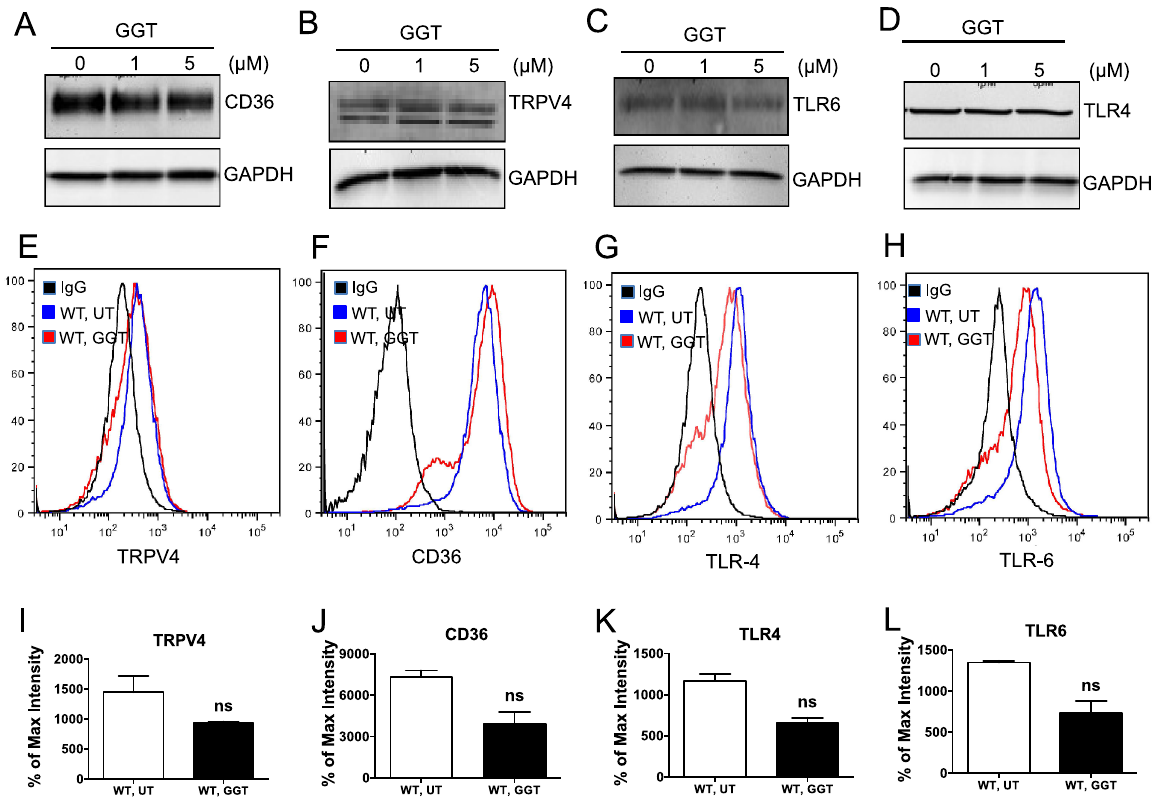
Figure 3. Ginkgetin treatment does not alter total protein or surface expression of TRPV4, CD36, and TLRs in macrophages. ( A – D ) Immunoblots of macrophage whole cell lysates following overnight treatment with 1 or 5 µM ginkgetin or vehicle. Representative immunoblots show total protein expression of CD36 ( A ), TRPV4 ( B ), TLR6 ( C ) and TLR4 ( D ) in ginkgetin-treated and untreated cells. Three independent biological replicates and 3 experimental repeats for each set of experiment were performed. ( E – H ) Flow cytometric analysis of macrophages treated overnight with 5 µM ginkgetin or untreated showing surface expression of TRPV4 ( E ), CD36 ( F ), TLR4 ( G ), and TLR6 ( G ) in untreated and ginkgetin-treated cells. Three independent biological replicates and 30,000 cells per condition were analyzed. ( I – L ) Quantitative analysis of results from ( E – H ). Analyzed by Two-tailed t-test with 99% confidence interval. Cells counted per experiment, 30,000; two experimental